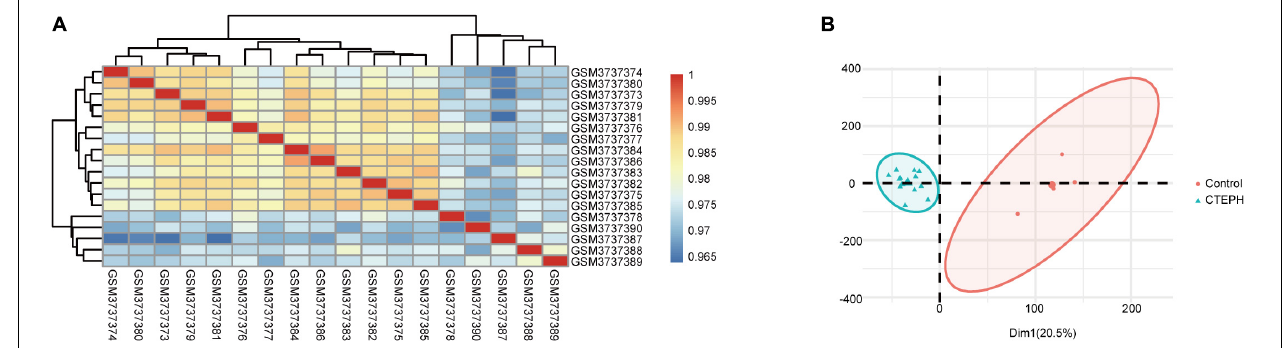
FIGURE 1 | Intra-sample data repeatability test for GSE130391 by Pearson’s correlation analysis and PCA. (A) All samples from the GSE130391 dataset were analyzed using Pearson’s correlation analysis. Colors represent the correlation coefficient. (B) All samples from the GSE130391 dataset were analyzed using PCA. PC1 and PC2 are represented on the X -axis and Y -axis, respectively. PCA, principal component analysis; PC1, principal component 1; PC2, principal component